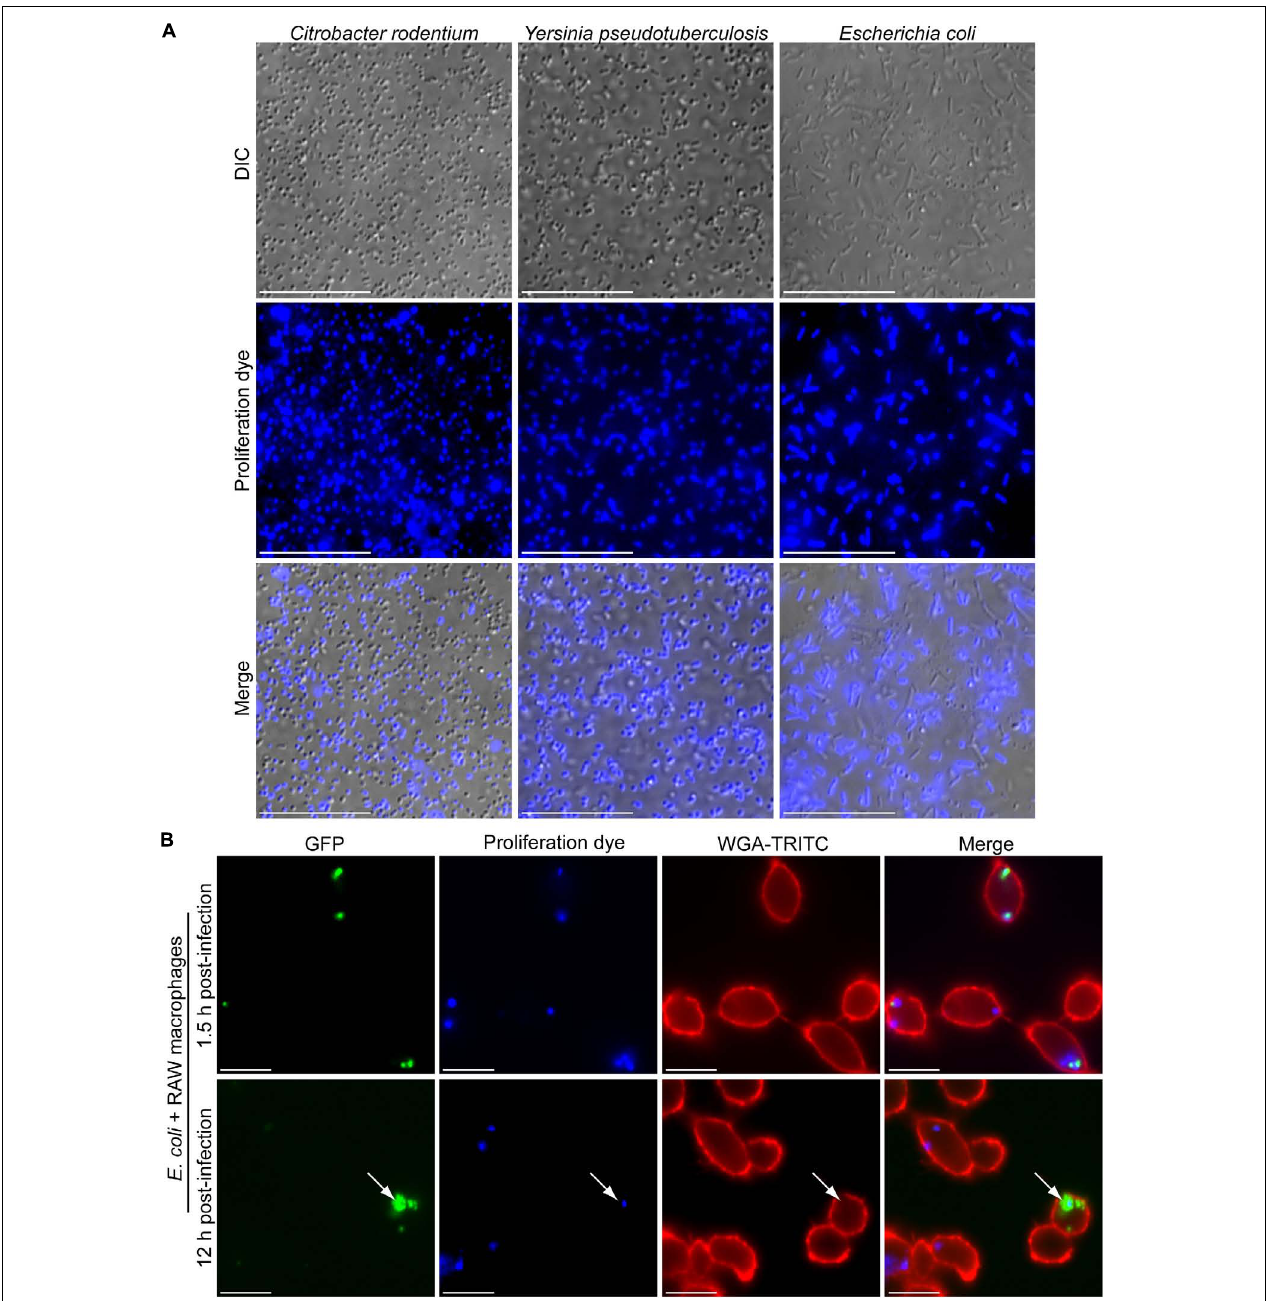
FIGURE 7 | Gram-negative bacteria are amenable to fluorescence-based proliferation assays. In (A) the micrographs depict C. rodentium , Y. pseudotuberculosis , and E. coli DH5 α bacteria that were incubated with eFluor TM -670 proliferation dye for a period of 10 min. In (B) the fluorescent micrographs depict intracellular E. coli ML35 expressing GFP (in green) that are co-labeled with the eFluor TM -670 (in blue). At 1.5 h post-infection (top row) and 12 h post-infection (bottom row) eFluor TM -670 positive bacteria can be detected. The white arrow points to a rare instance where GFP-positive yet eFluor TM -670-negative E. coli could be detected within RAW macrophages marked with TRITC-WGA (in red). These micrographs are representative of two independent experiments. Scale bars are ∼ 10 µ